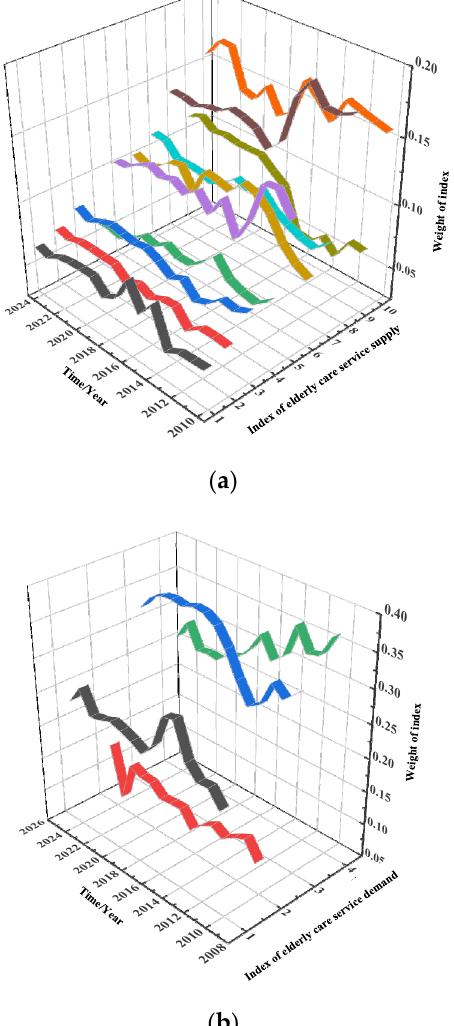
Figure 2. Supply and demand coupling coordination in each region from 2010 to 2019. ( a ) Supply index of elderly care service X. ( b ) Demand index of elderly care service Y.